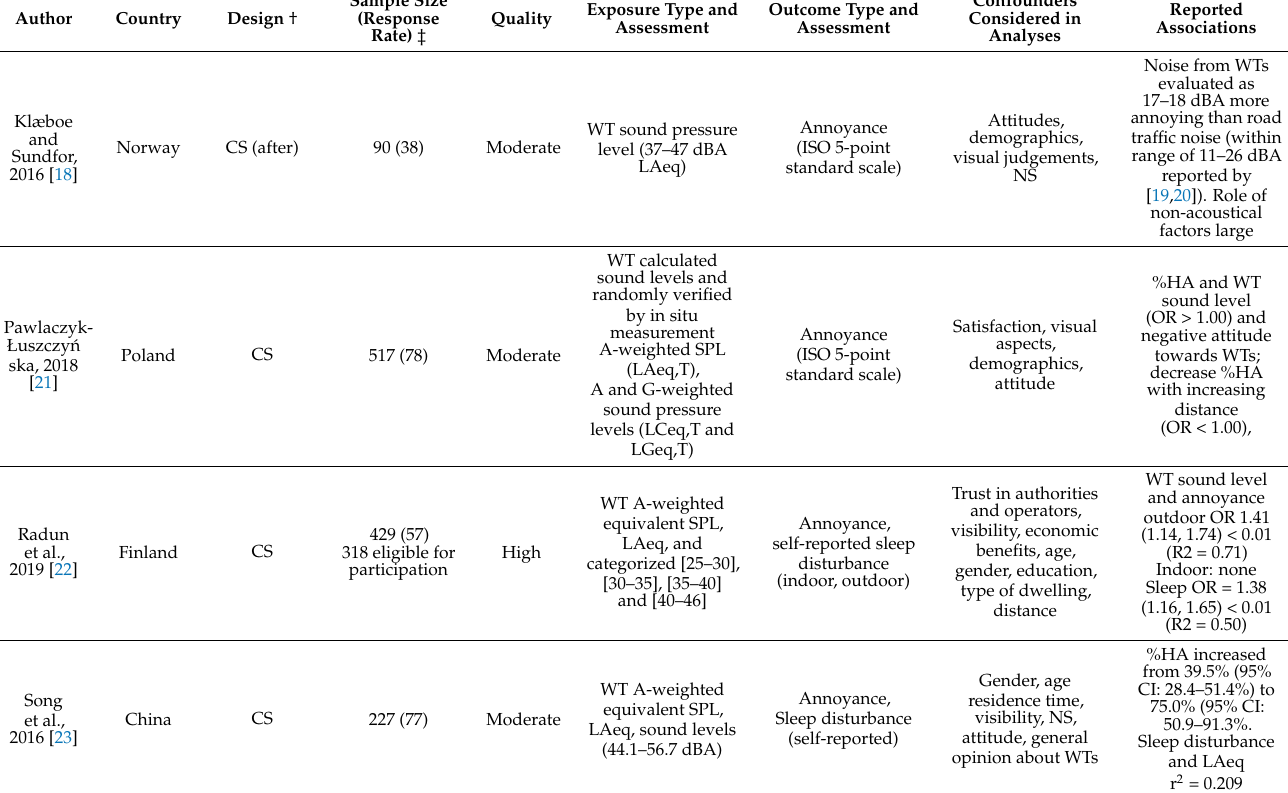
Table 2. Overview of the characteristics of the selected studies on WT sound and